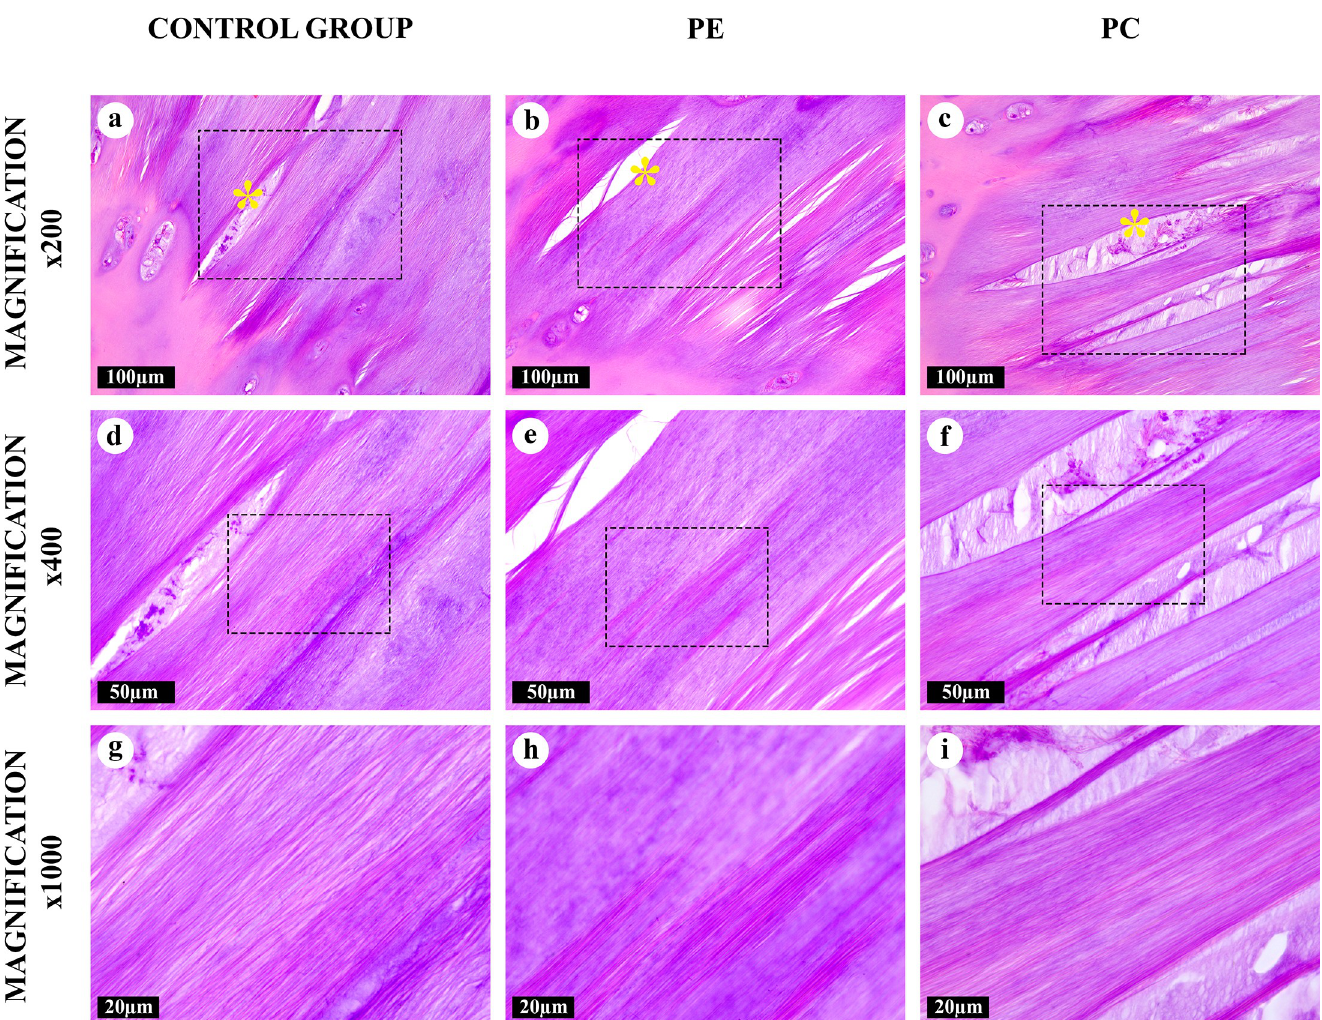
Fig 2. “Canonical” amianthoid transformation areas in the costal cartilages, hematoxylin and eosin. The chondron structure was absent. Aligned AFs were both eosinophilic and basophilic. Degenerating cartilaginous lacunae formed lens-shaped cavities ( � ) surrounded by AFs. Some cavities were filled with cellular detritus.